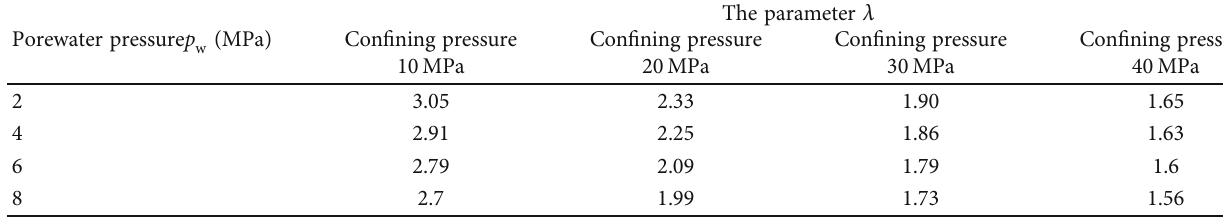
Table 1: The parameter λ under di ff erent water and force